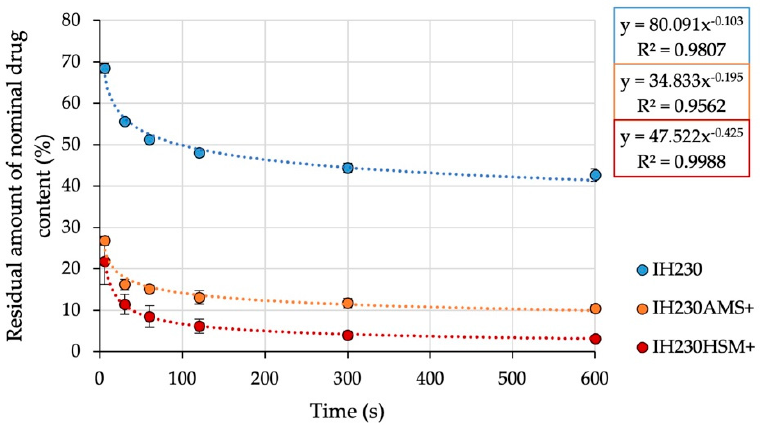
Figure 9. Residual amount of nominal drug content of respective interactive blends (percentage of nominal drug content) in dependence of the time dispersed by the AJS. n = 3, error bars show SD.